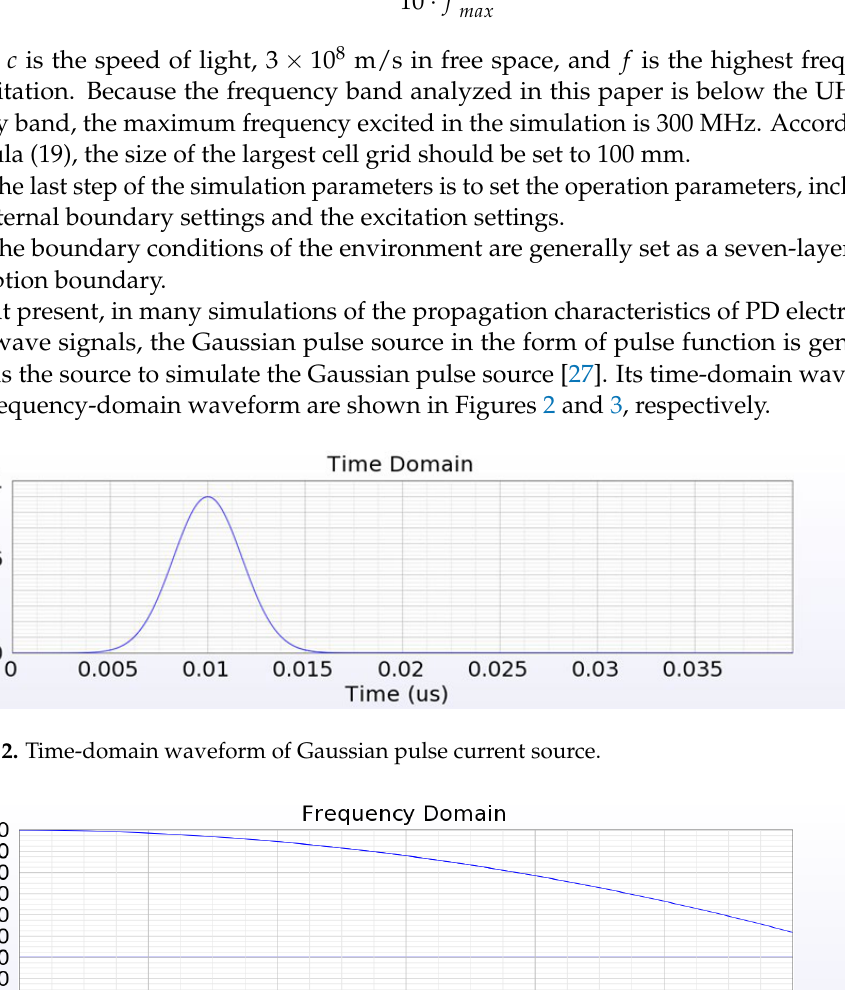
Figure 4. PD electromagnetic wave signal received by near - field probe . 4. Analysis of Simulation Results 4.1. Influence of Current Transformer on Near-Field Propagation Characteristics of PD Electromagnetic Wave Set the position of the PD excitation source on the surface of the middle of the current transformer; the specific position is (25 m m, −100 m m, 0 mm), and the length of the source is set as 10 mm. Then , place the No. 1 point sensor 15 mm from the front of the source; its specific position is (50 m m, −100 m m, 0 mm) . Then , place the No. 2 point sensor 325 m m